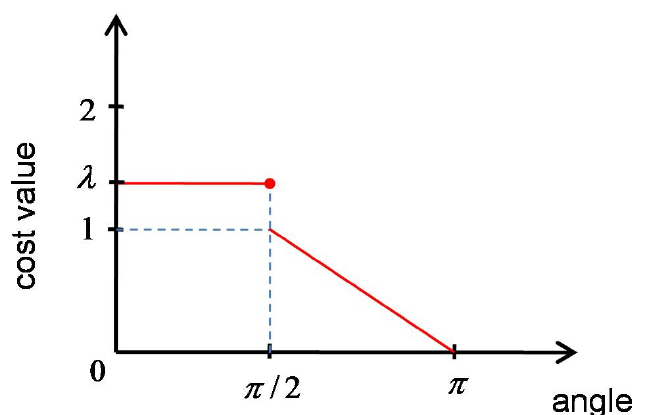
Figure 3. Defined function to measure the cost between a camera and a polygon edge. The maximum cost is equal to λ and happens when α < = π/ 2 or in other words the edge is invisible by the